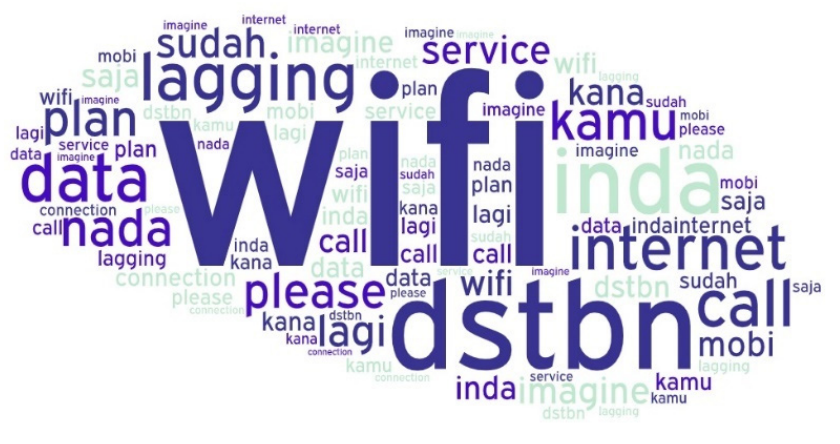
Figure 8. Word cloud as word list.